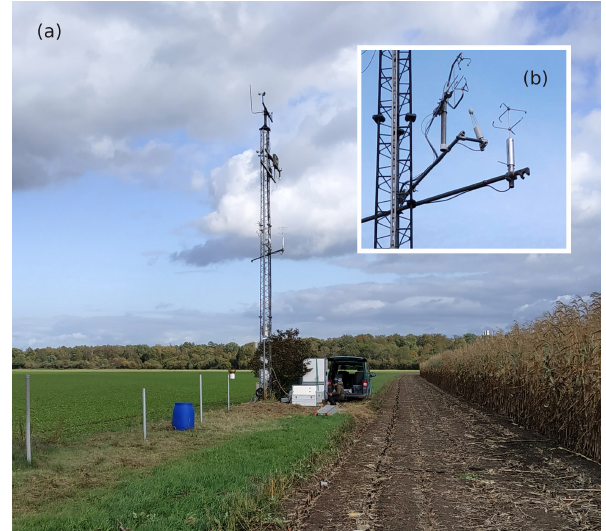
Figure 2. Photograph of the experimental field site showing the measurement tower (a) and a close-up of the flux instruments mounted on the tower (b) . The status of the vegetation seen in the picture is not representative of the measurement